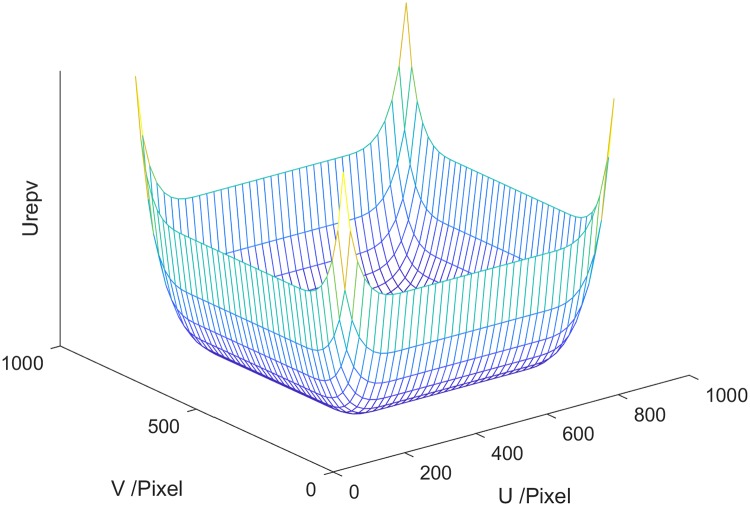
The repulsion field of the visual field constraint.